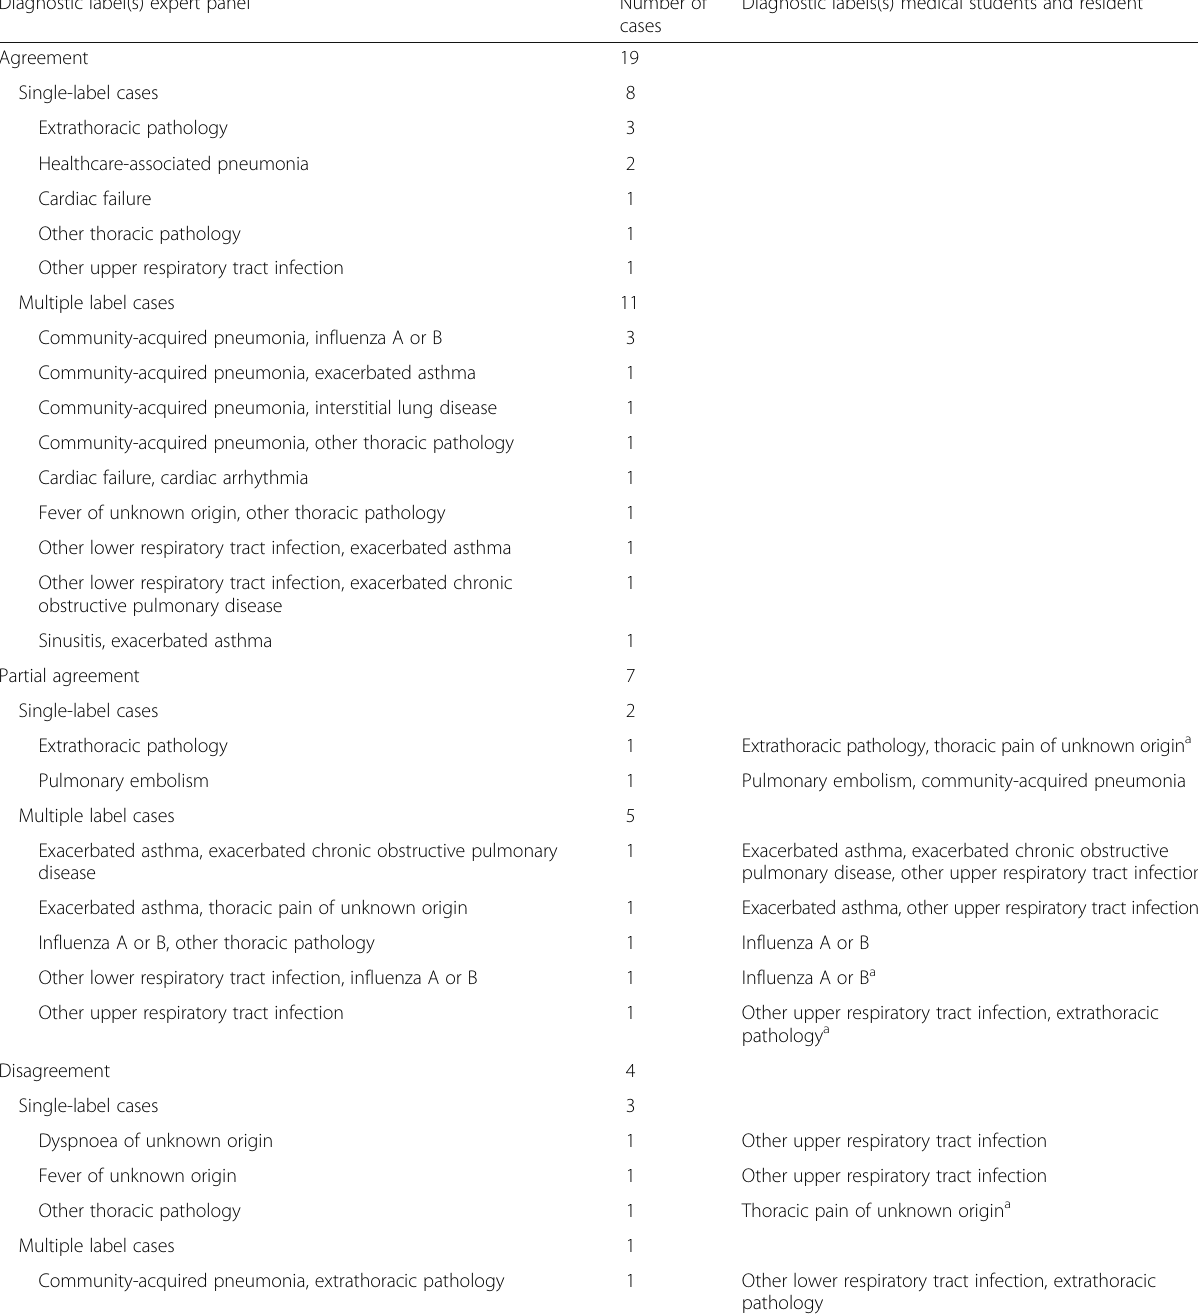
Table 2 Classification by medical students and a resident as compared to classification by the expert panel ( n = 30) Diagnostic label(s) expert